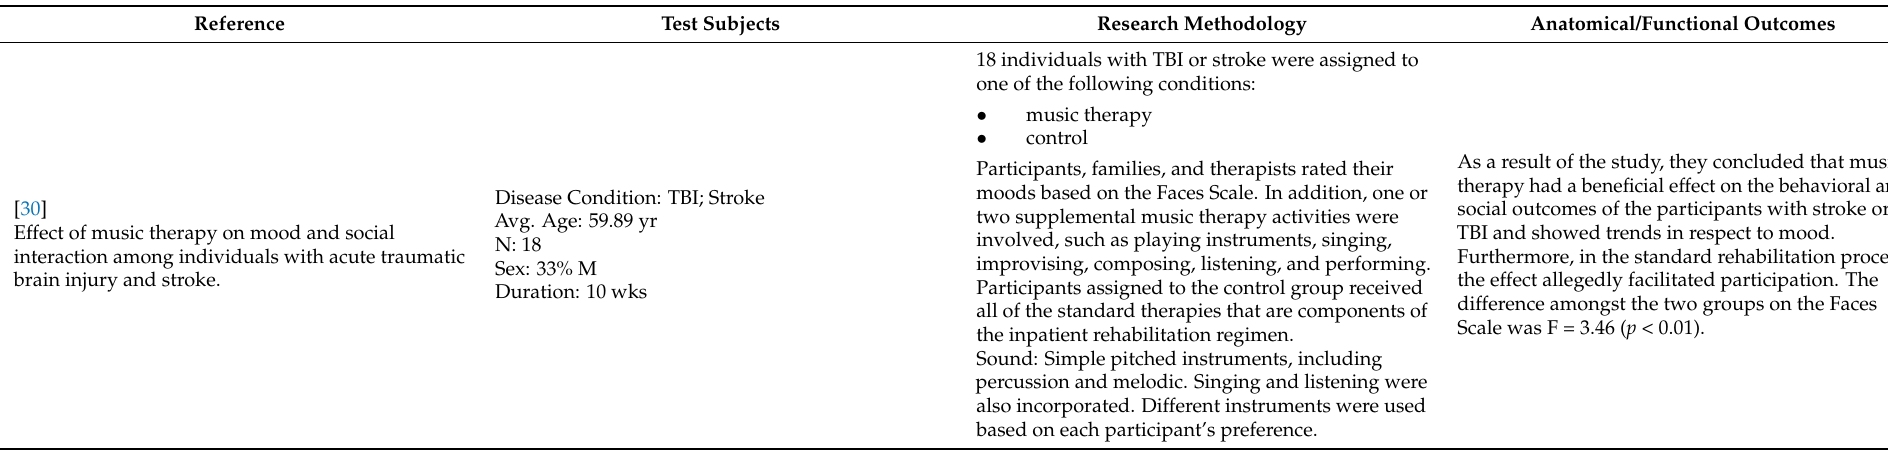
Table 2. Studies that provide insight into music/sound and the meningeal/glymphatic system in humans. Overview of all studies that showcase the effect of music on the glymphatic system. Each study is broken down based on the overall purpose and the selected sample, design, and study